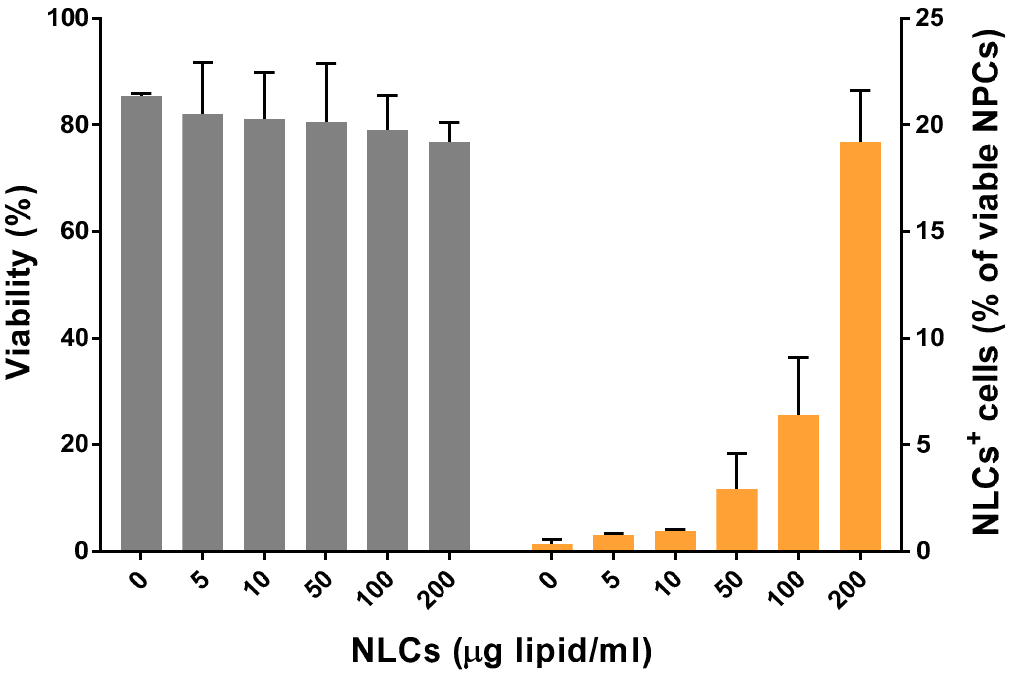
Figure 6. NLCs are internalized by NPC in a dose-dependent manner and are devoid of cytotoxic activity. NPCs were incubated for 24 h with NLCs at concentrations between 0 and 200 µg/mL to evaluate potential cytotoxic effects (left y -axis). In the same concentration range, DiD-labeled NLCs were used to study cellular uptake (right y -axis). NLCs concentrations are expressed as µg of MM (solid lipid) per mL. Data are the means ± SEM obtained in 3 independent experiments.